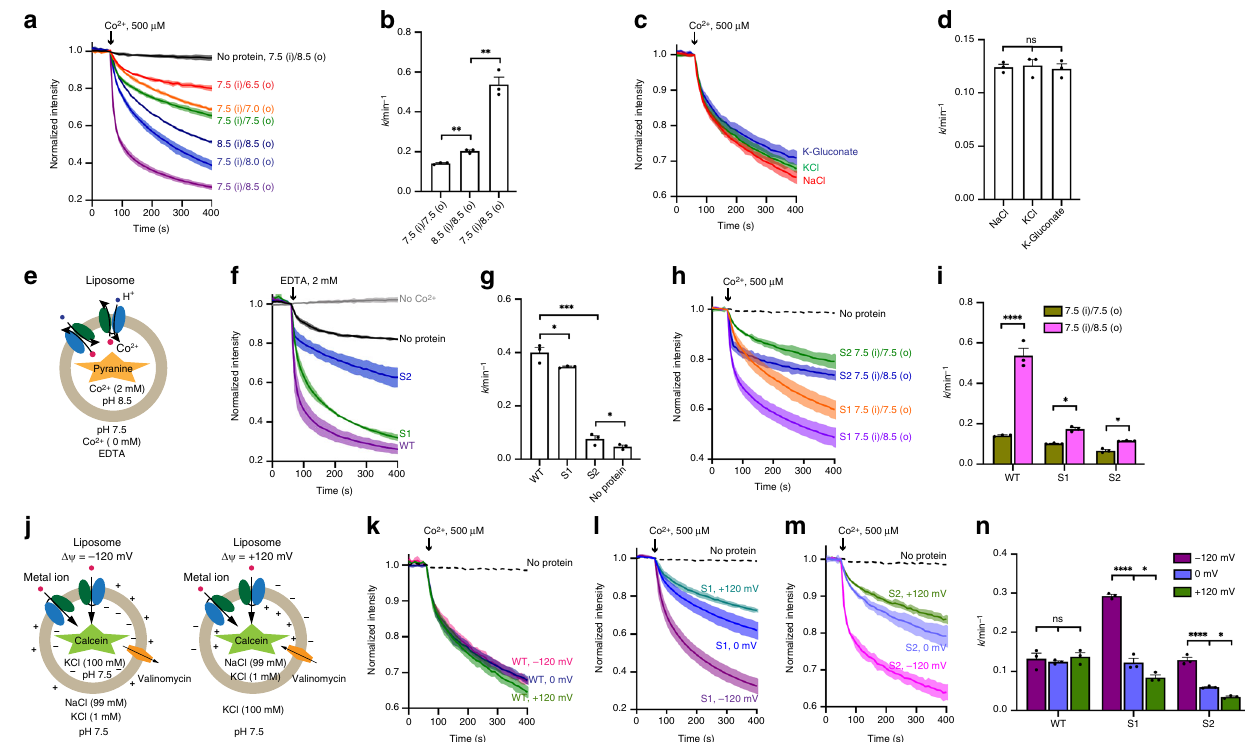
Fig. 4 TsFpn is a H + /Fe 2 + antiporter. a Quench of calcein fl uorescence in different external and internal pH conditions. b Initial rate constants of Co 2 + uptake in different pH gradient. Two-tailed Student ’ s t test: ** p < 0.01. c Quench of calcein fl uorescence under symmetrical KCl, symmetrical NaCl, and symmetrical K-Gluconate. d Initial rate constants of Co 2 + uptake in buffer with different ions. One-way ANOVA: no signi fi cant difference ( p = 0.89). e Schematic view of a fl ux assay that monitors H + in fl ux when Co 2 + fl ows out of the liposomes. f Quench o f pyranine fl uorescence for liposomes that with the wild-type TsFpn (WT, purple), S1 mutant (S1, green), S2 mutant (S2, blue), and no protein (black). g Initial rate constants of H + uptake of WT and mutants. Two-tailed Student ’ s t test: * p < 0.05; *** p < 0.001. h Quench of calcein fl uorescence in liposomes with the S1 mutant in symmetrical pH 7.5 (orange) and pH 7.5 (i)/ 8.5 (o) (purple), and with the S2 mutant in symmetrical pH 7.5 (green) and pH 7.5 (i)/ 8.5 (o) (blue). i Initial rate constants of Co 2 + uptake of WT and mutants in different pH gradient. Two-way ANOVA: among different proteins, p < 0.0001; between different pH gradients, p < 0.0001; interaction, p < 0.0001; the pH 7.5 (i)/ 8.5 (o) differs from the symmetrical pH 7.5 in WT ( p < 0.0001), S1 ( p = 0.022), and S2 ( p = 0.041). j Schematic view of TsFpn-containing proteoliposomes with − 120 mV membrane potentials (left) and + 120 mV (right). k – m Quench of calcein fl uorescence over time measured in three membrane potentials for the wild type ( k ), the S1 ( l ) and S2 ( m ) mutant. n Initial rate constants of Co 2 + uptake of WT and mutants at − 120 or + 120 mV. Two-way ANOVA: among different proteins, p < 0.0001; among different membrane potentials, p < 0.0001; interaction, p < 0.0001; within each group, statistical signi fi cances are indicated: ns not signi fi cant; * p < 0.05; **** p <